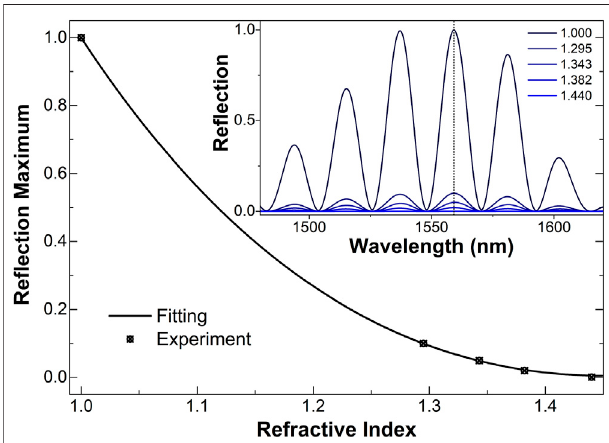
FIGURE 3 | Measured maxima of the interference patterns shown in the inset graph as a function of refractive index. The solid line is a fi tting to the experimental data which was calculated with Eq. 3 . The dotted vertical line shows the maxima of the interference patterns.